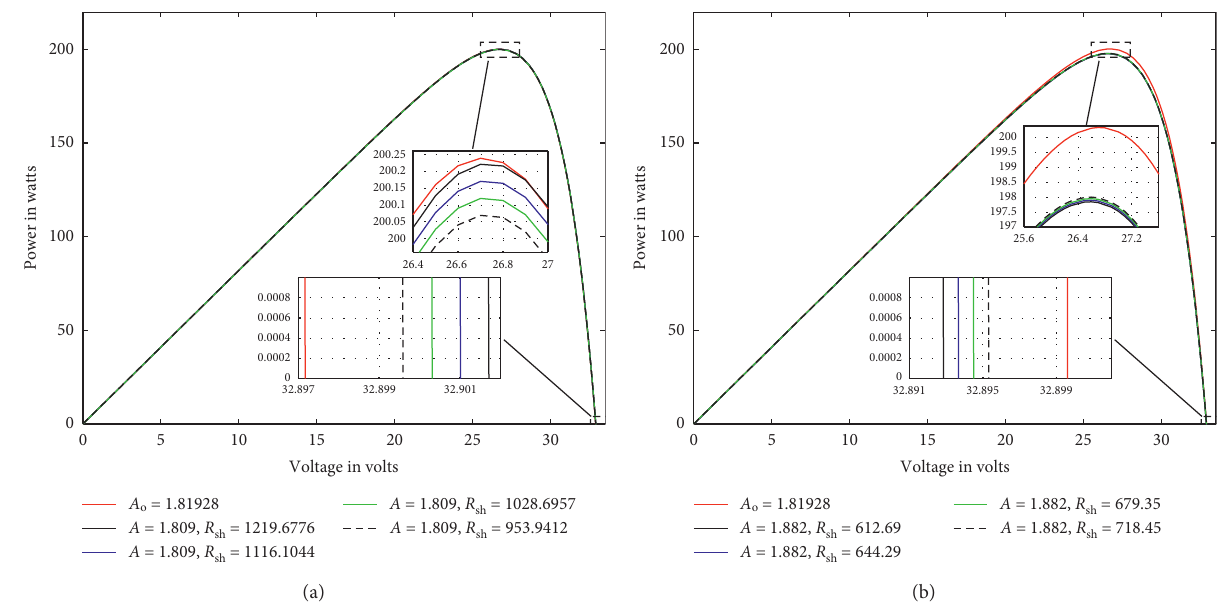
Figure 6: PV curves for KC200GT showing different ( R